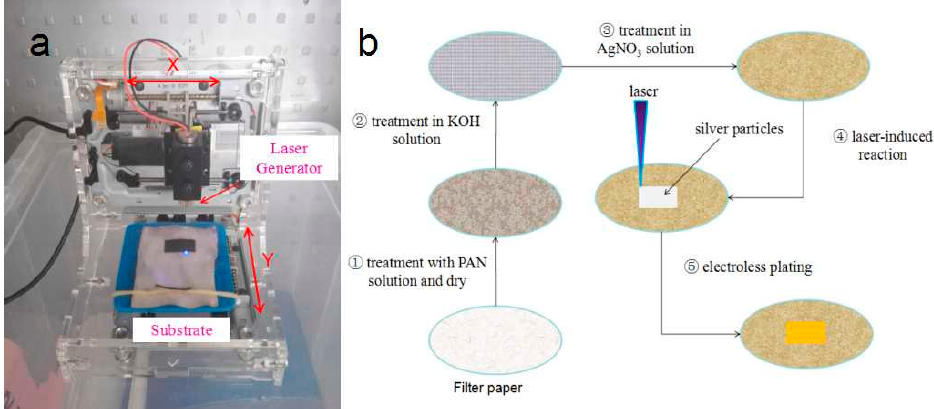
Figure 1. ( a ) Laser-induced set-up; and ( b ) diagram of the laser-induced and electroless